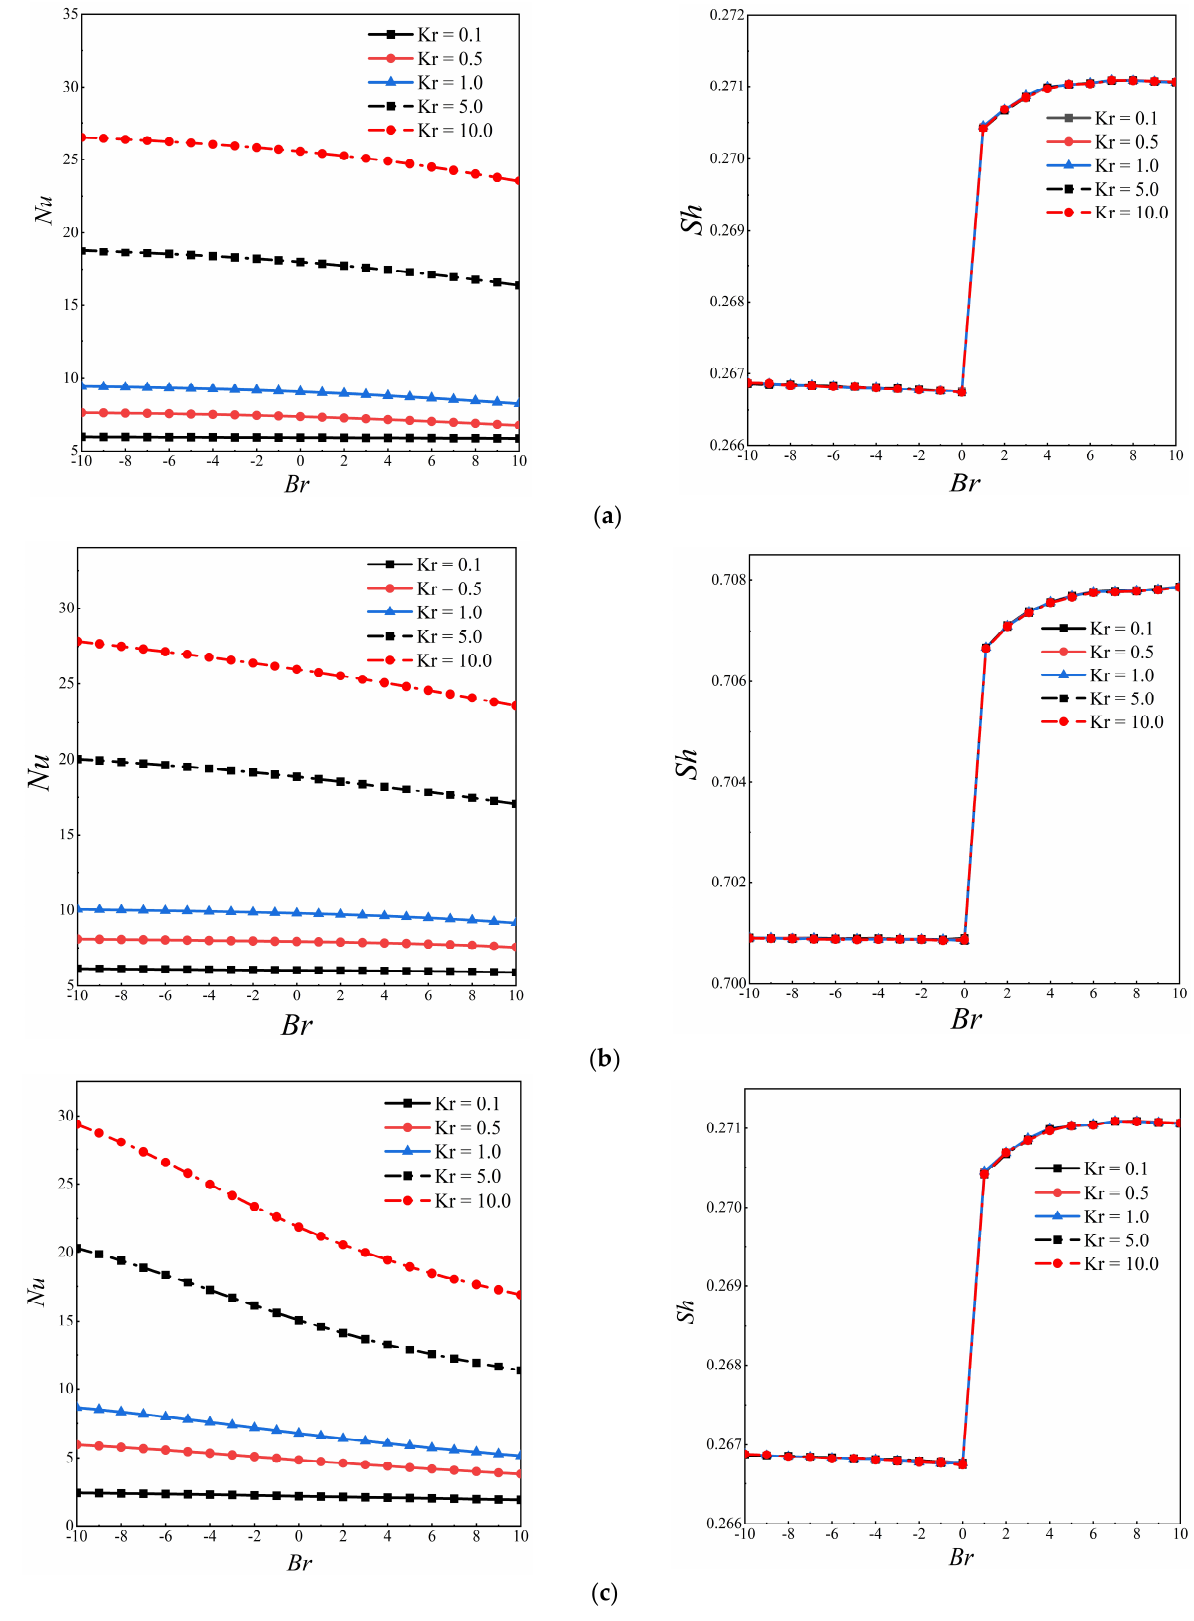
Figure 8. The effect of porous ‐ fluid thermal conductivity ratio and buoyancy ratio on heat and mois ‐ ture transfer for three types of porous media arrangement at Ri = 1, Kc = 1, and Da = 10 − 3 . ( a ) Type A, ( b ) Type B, ( c ), and Type C.